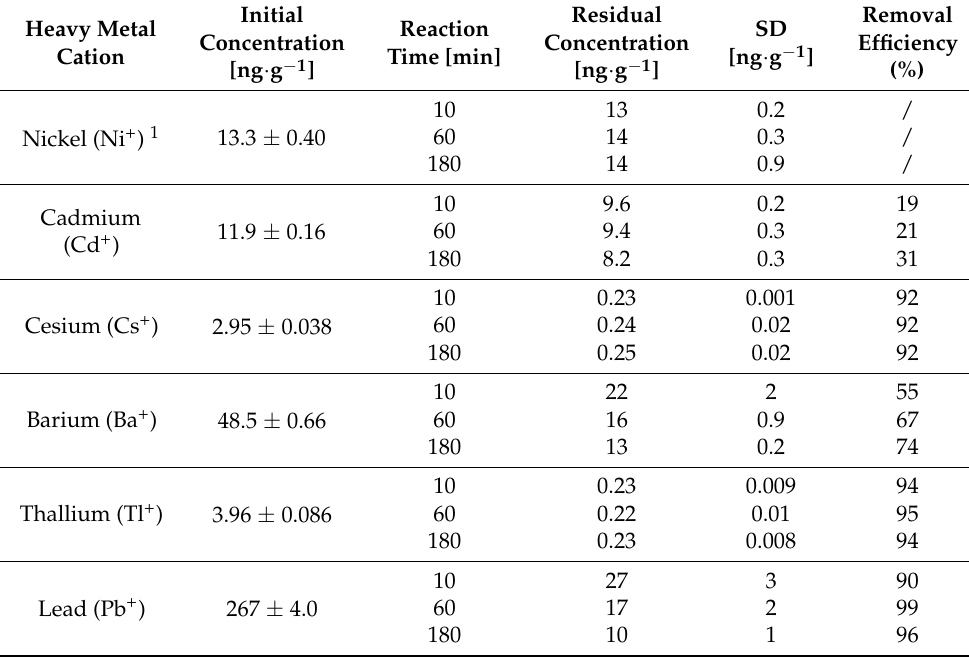
Table 10. Adsorption kinetics of studied heavy metal cations from heavy-metal-contaminated non- carbonated mineral water onto NPCT1.